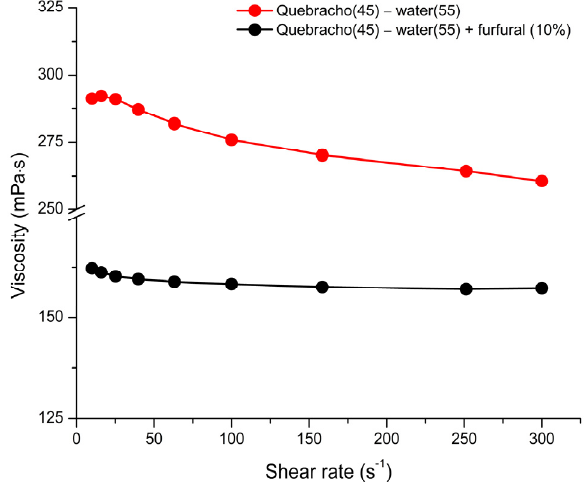
Figure 2. Viscosity of 45% tannin − water solutions at pH = 8 with (black) and without (red) furfural hardener.